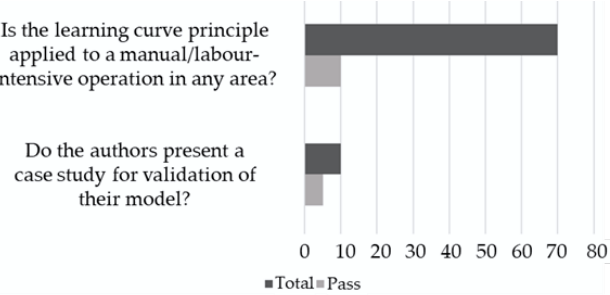
Figure 11. Quality check of complying journal articles and conference papers for Domain 1.